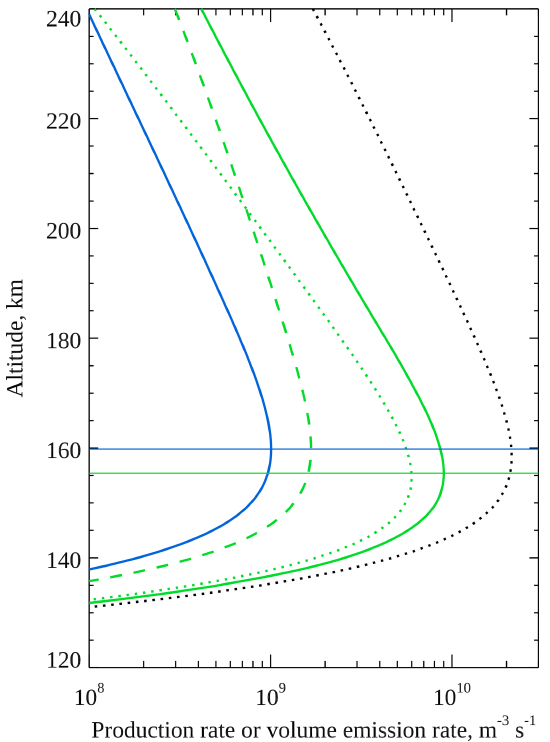
Figure 10. Modelled volume emission rate height profiles of the 427.8nm blue line (solid blue) and 557.7nm green line (solid green) using a 900eV Gaussian electron precipitation spectrum. The hor- izontal lines mark the peaks of the volume emission rate profiles. Also shown are the production rates of O( 1 S ) by energy transfer from N 2 ( A ) (dotted green) and electron impact on O (dashed green) and the production rate of N 2 ( A ) (dotted